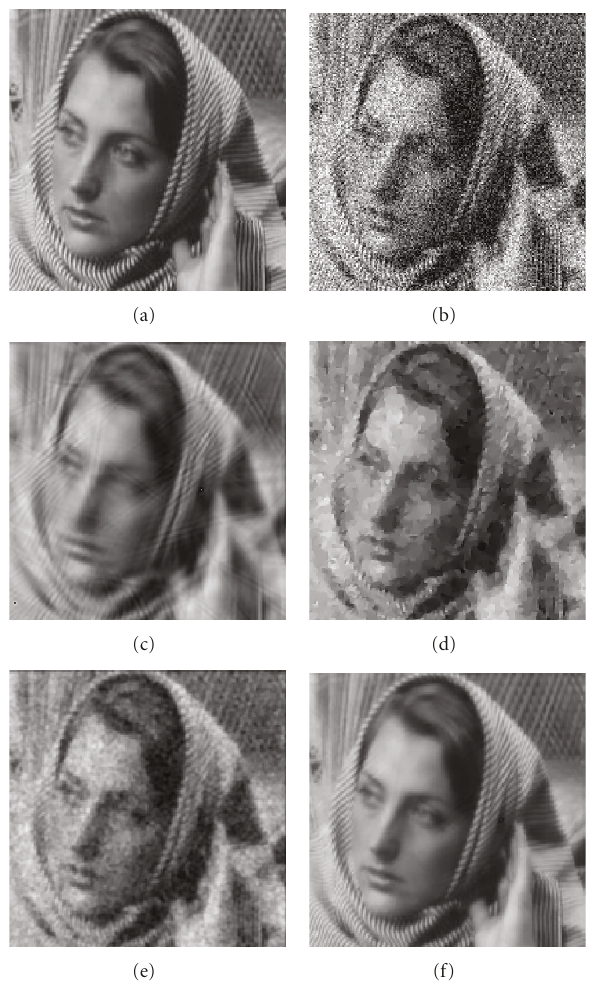
Figure 14: The subimages of the original, noisy, and restored “Barbara” images: (a) the original image; (b) the noisy image (SNR = 2.71, MSSIM = 0.26); (c) the restored image by Curvelet Shrinkage method (SNR = 10.45, MSSIM = 0.68); (d) the restored image by using the “TV” model (SNR = 10.12, MSSIM = 0.61); (e) the restored image by using the “TVGF” model (SNR = 9.93, MSSIM = 0.56); (f) the restored image by using our proposed model (SNR = 10.81, MSSIM = 0.70).